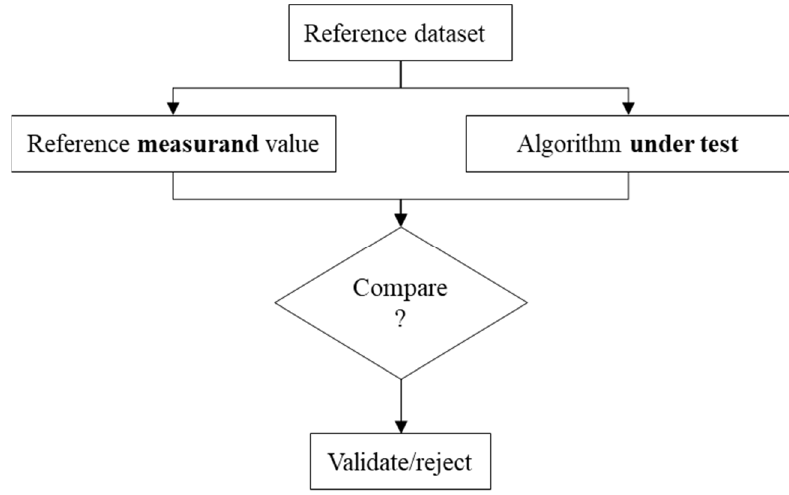
Figure 2. Illustration of the type F1 algorithm measurement standard.